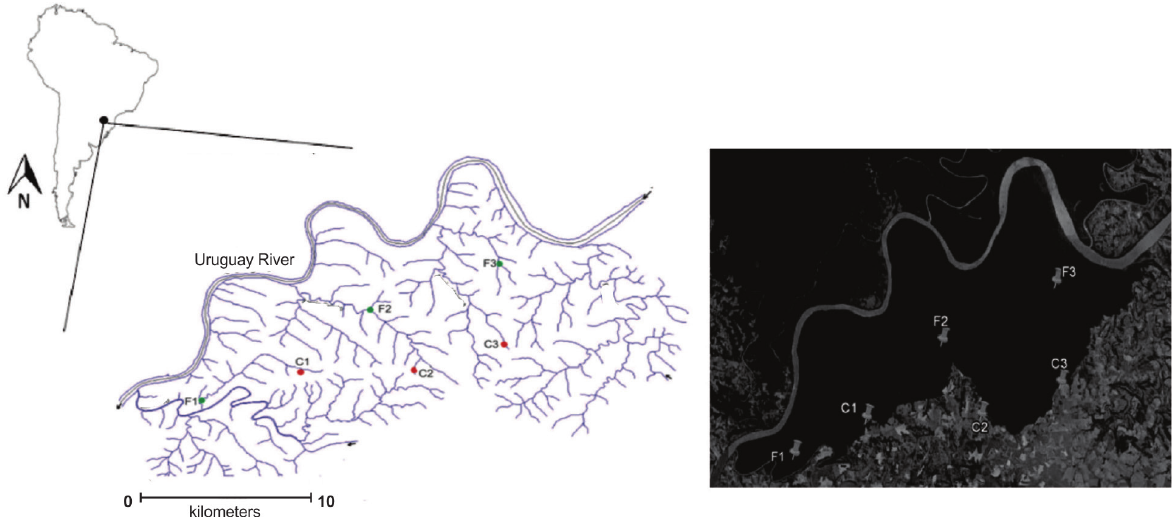
Figure 1 - Location of the sampled streams in forested (F1, F2, and F3) and converted areas (C1, C2, and C3) at Parque Estadual do Turvo and adjacent areas, in Southern Brazil. Adapted from: Bertaso et al.